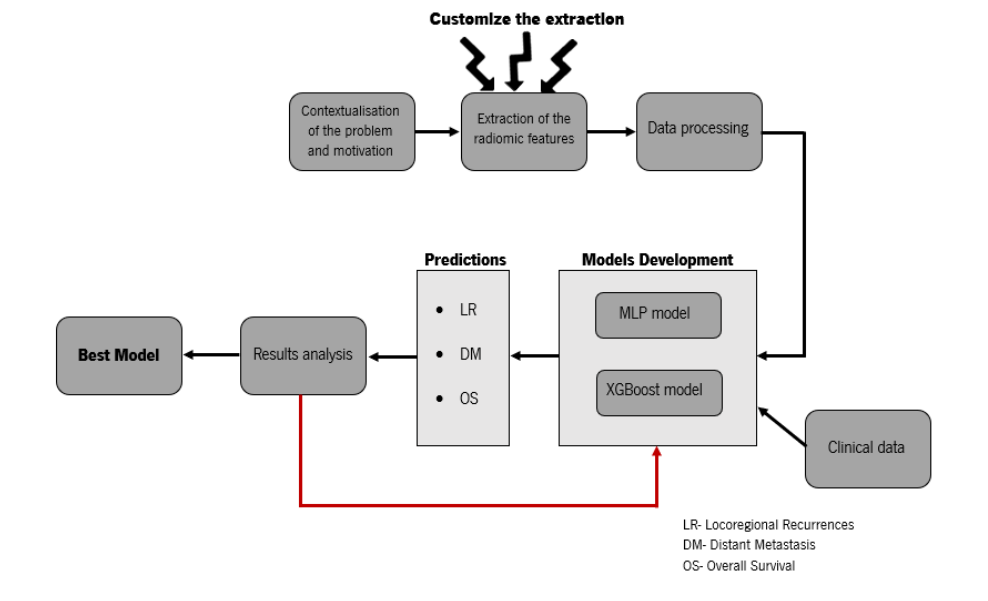
Figure 1. Basic scheme of the workflow for the development of the contribution. The clinical data could include: gender, age, time between diagnosis and start of treatment, and TNM stage. Extraction of radiomic features can be performed with many medical imaging modalities, such as